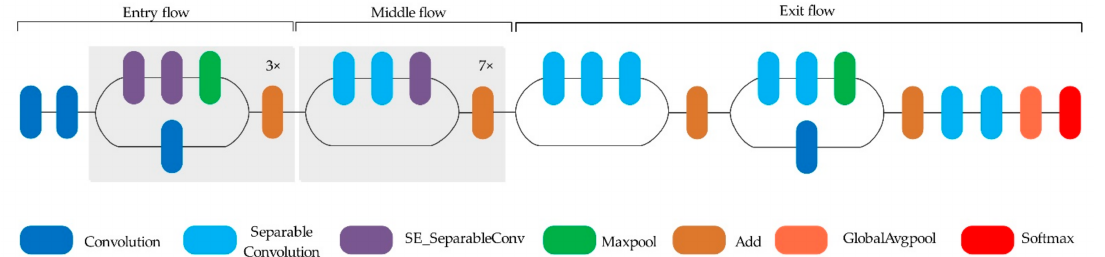
Figure 4. The network structure of SE_Xception fused by the proposed SE-DEEP block and Xception network. Note that we only replace some of the SeparableConv (depth-wise separable convolution) layers with SE_SeparableConv (SE-DEEP block) layers in Xception, and did not change their width, depth and kernel size.